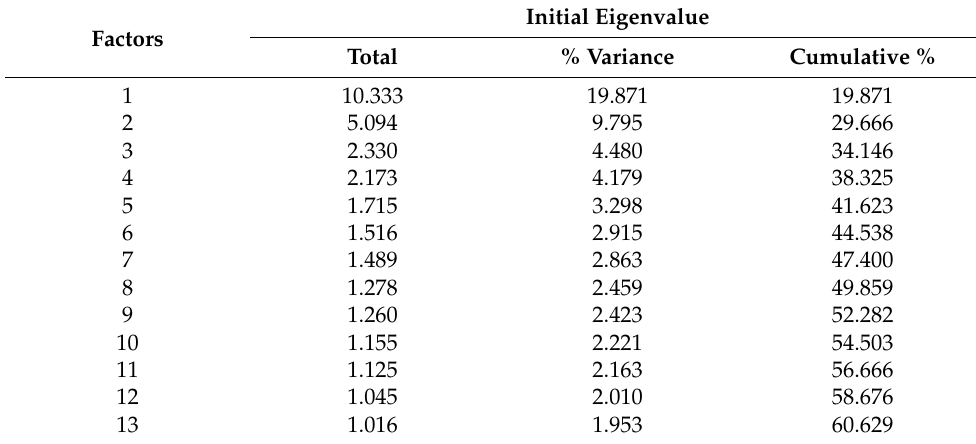
Table 2. The exploratory factor analysis result of the QRS-F.